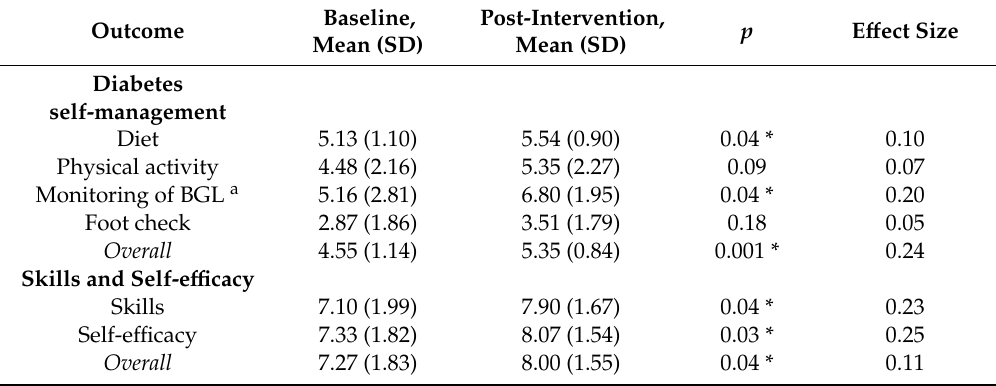
Table 1. Observed mean and standard deviations for the outcome